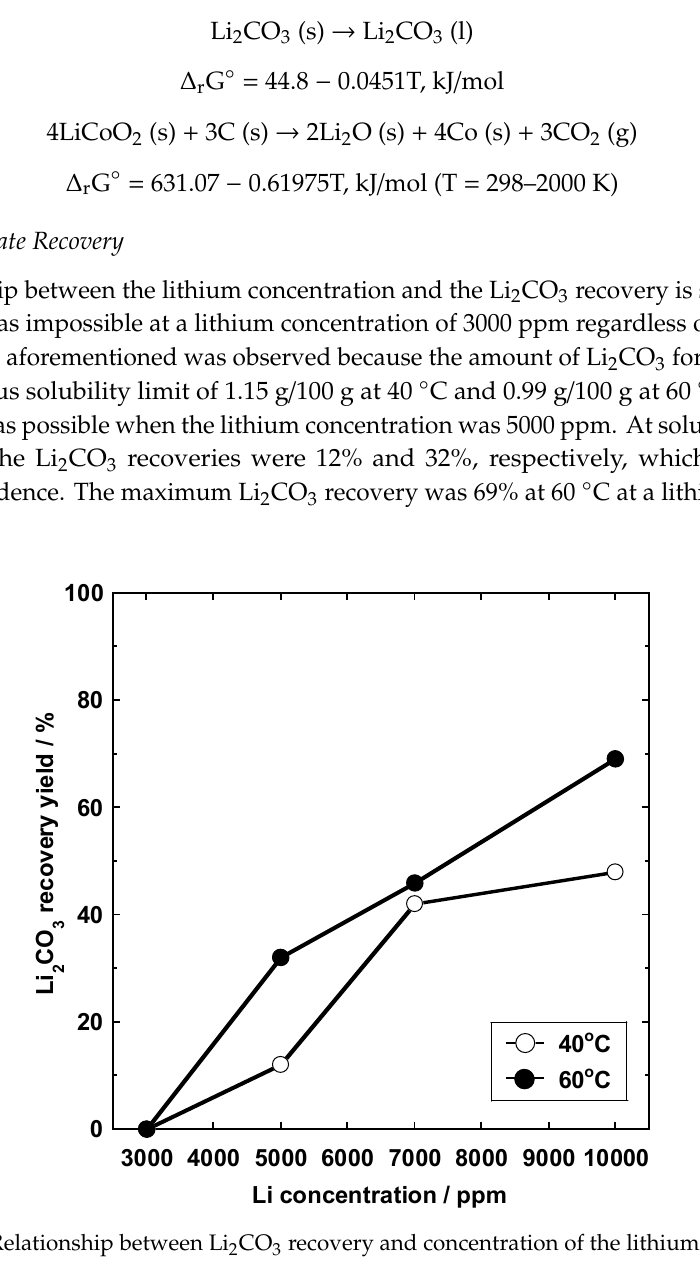
Figure 8. XRD profiles of ( a ) the Li 2 CO 3 reagent and ( b ) the precipitate. 3.6. Relationship between the Concentration of the Fluorine Solution and the Lithium Carbonate Concentration